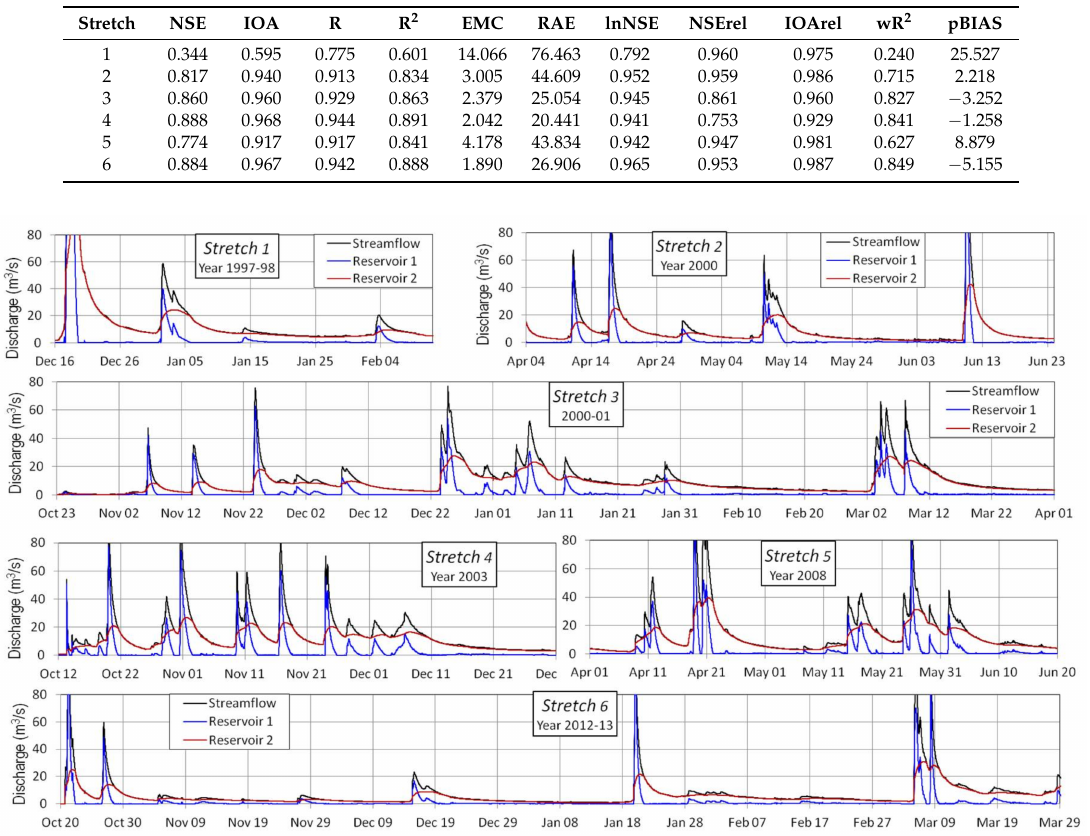
Figure 7. Flow separation for the six stretches selected of the time series with the Filter